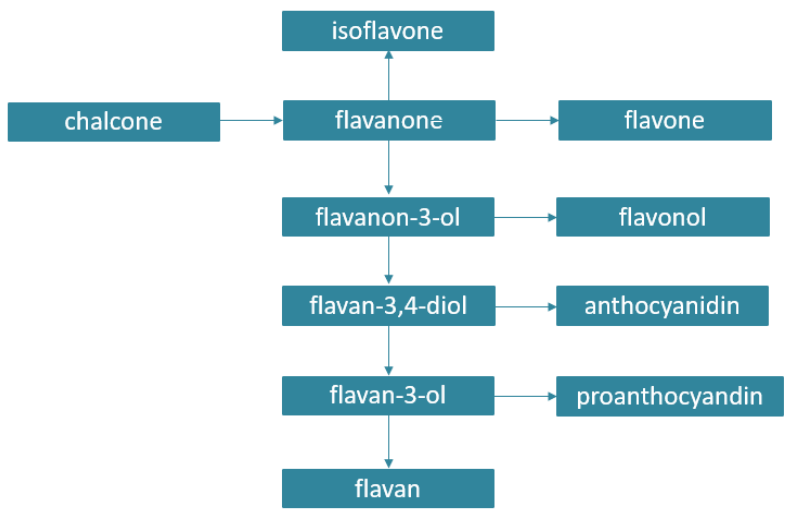
Figure 2. Biosynthetic origin of flavonoids.